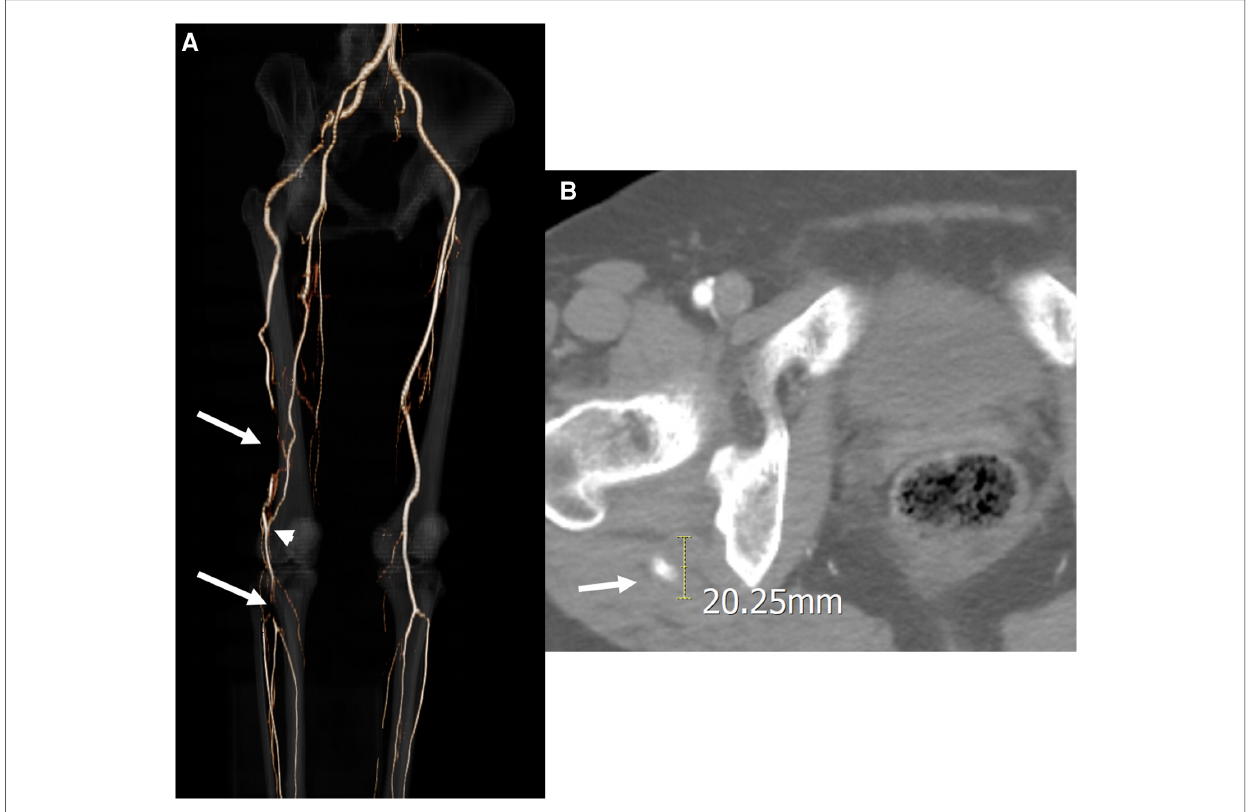
FIGURE 1 Initial computed tomography angiography (CTA) of the fi rst case. ( A ) Three-dimensional reconstruction image revealed a persistent sciatic artery (PSA) arising from the right internal iliac artery and two distal thromboembolic occlusions located at the distal PSA in the thigh and the popliteal artery at the trifurcation ( arrows ). A collateral arterial fl ow was detected between the two thromboembolic occlusions ( arrowhead ). ( B ) Axial CTA imaging revealed a PSA aneurysm 20 mm in diameter with a mural thrombus near the posterior part of the greater trochanter of the